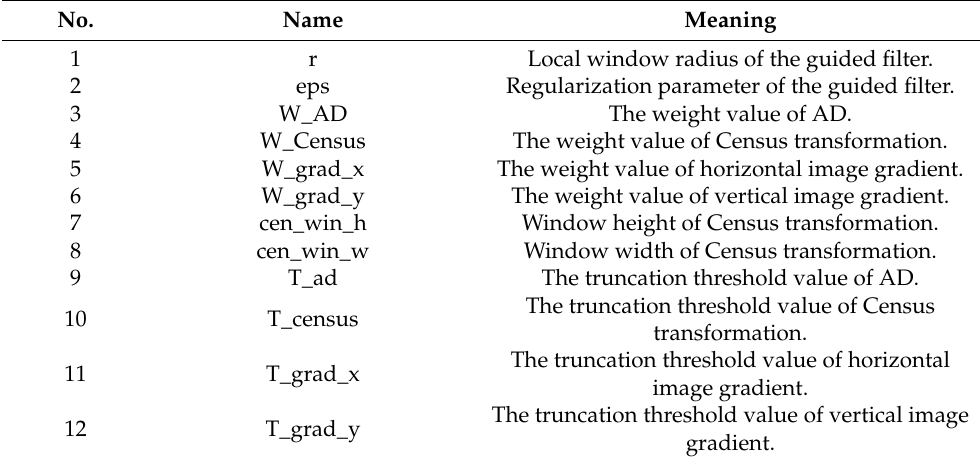
Table 1. Name and meaning of parameters in